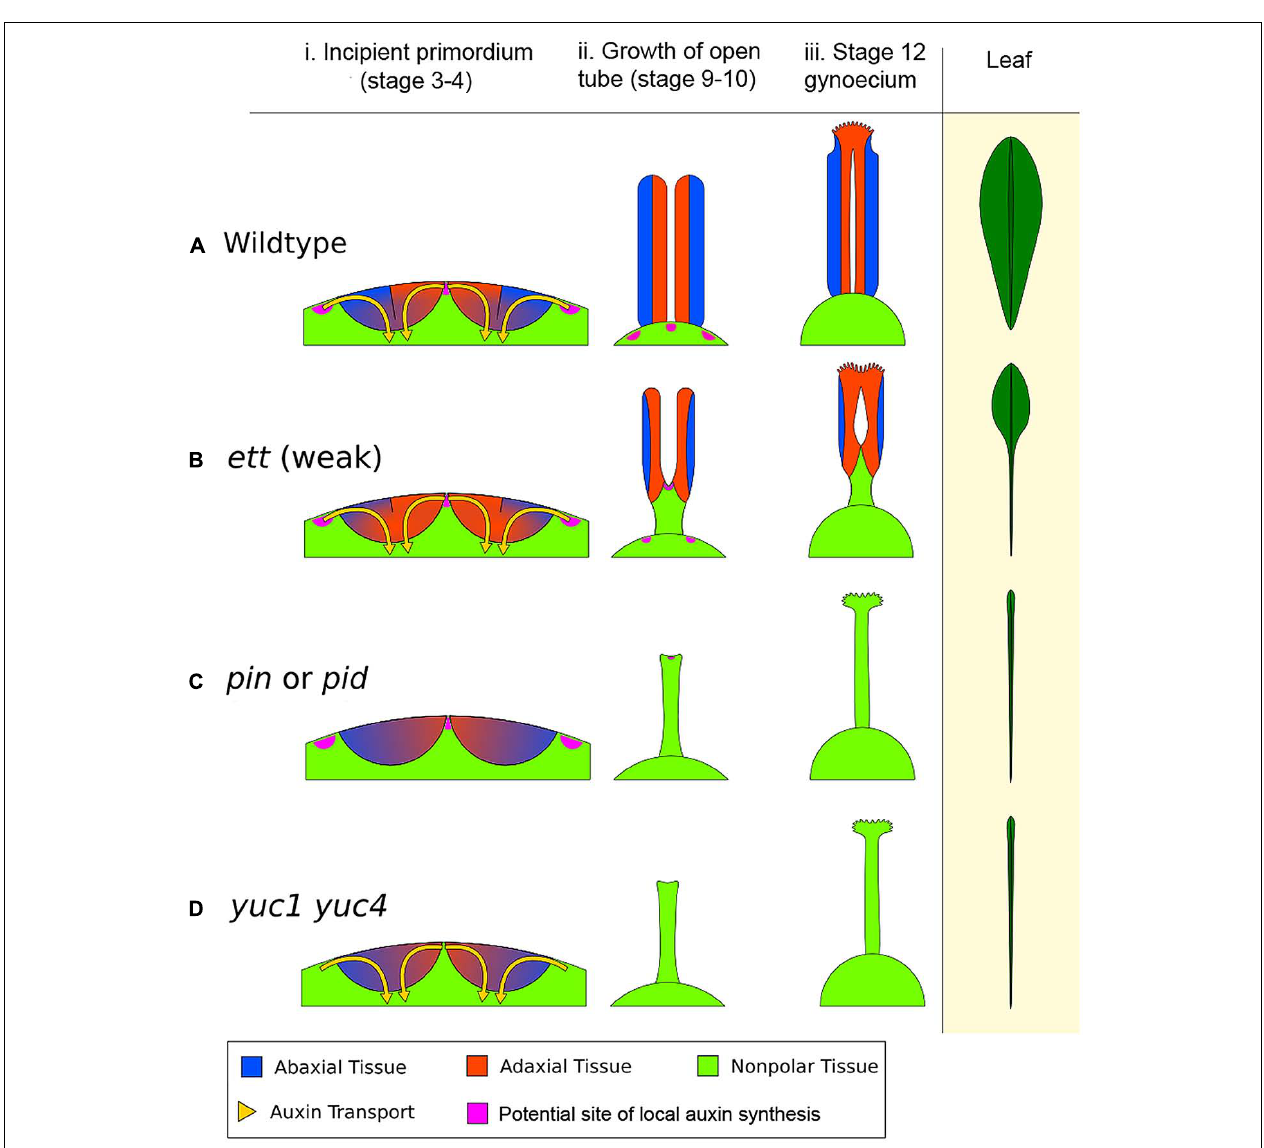
FIGURE 6 |The early action model of gynoecium patterning. (A) Wild type (WT) gynoecium development.The diagram in (i) depicts a young floral meristem giving rise to the two incipient carpel primordia, viewed as an enlarged longitudinal section of the floral meristem apex. InWT, opposing auxin flows (indicated by the yellow arrows) converge on the epidermal center of each carpel primordium.The convergence site likely marks the AD/AB boundary, shown as a black line between blue (AB) and orange (AD) domains.The sharp AD/AB boundary ensures upward growth of carpel tube, forming a long tube with AD domain facing interior (ii). Later the cylindrical tube differentiates into stigma/style at the apex and barely visible gynophore at the base (iii).The phenotypic analogy to a normal Arabidopsis leaf with lamina along its entire length is shown on the right. (B) In a weak ett mutant ( ett-2 ), abaxial identity is compromised (but not eliminated entirely), resulting in partial adaxialization of the carpel primordia indicated by expansion of orange color (AD) area (i). As a result, there is diminishing AD/AB boundary, indicated by a shorter boundary line (i). Consequently, only a small area of the carpel primordium near the primordial apex has a clear AD/AB boundary.This shorter (or fuzzier) AD/AB boundary results in limited upward growth and